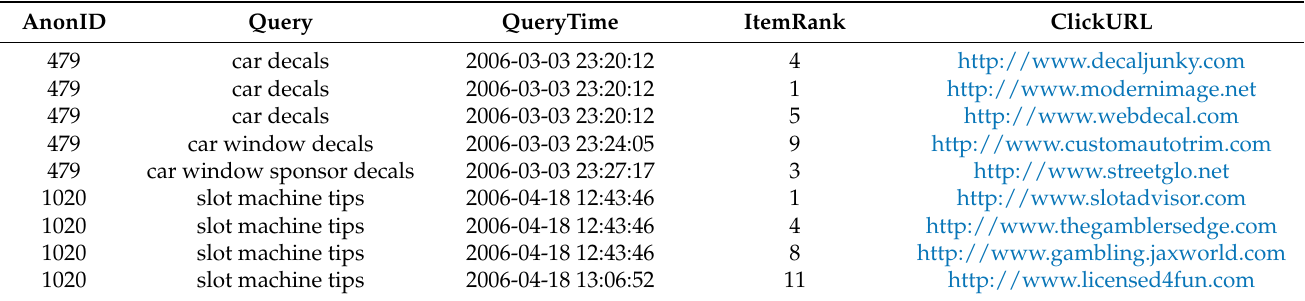
Table 2. The example of the AOL query log